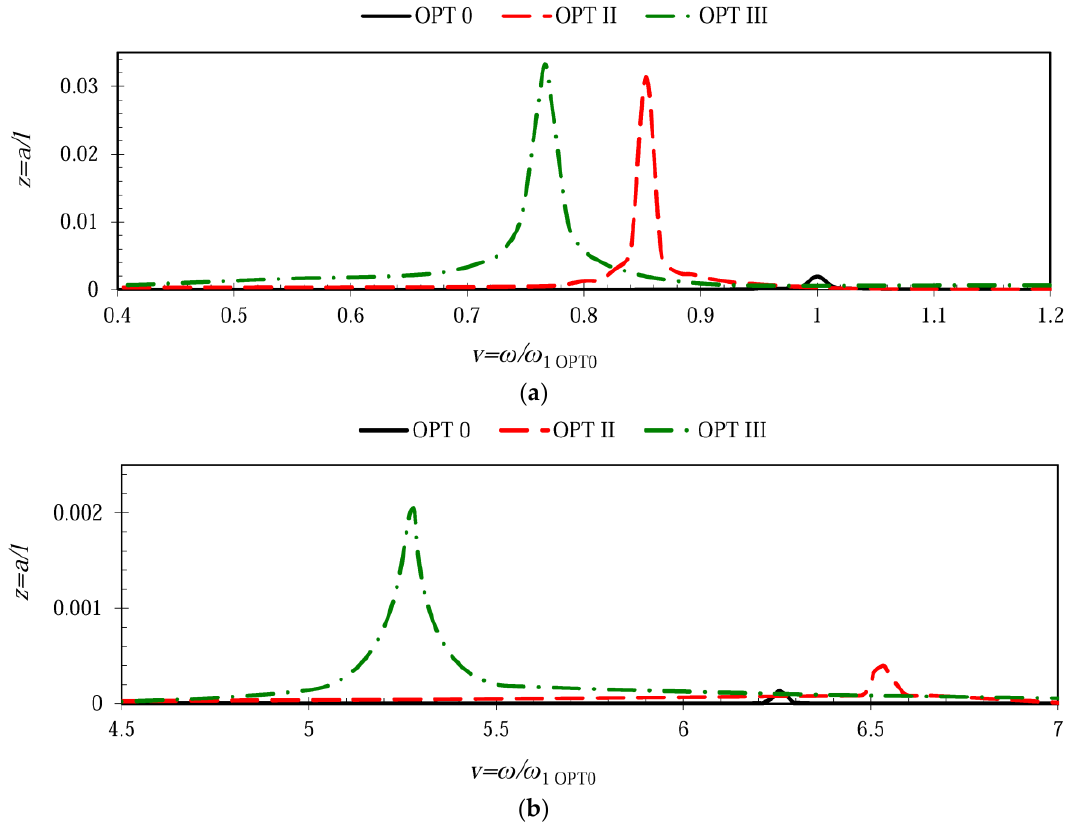
Figure 6. Shift of the natural frequencies for different microcantilever configurations: ( a ) shift of the 1st natural frequency; ( b ) shift of the 2nd natural frequency.